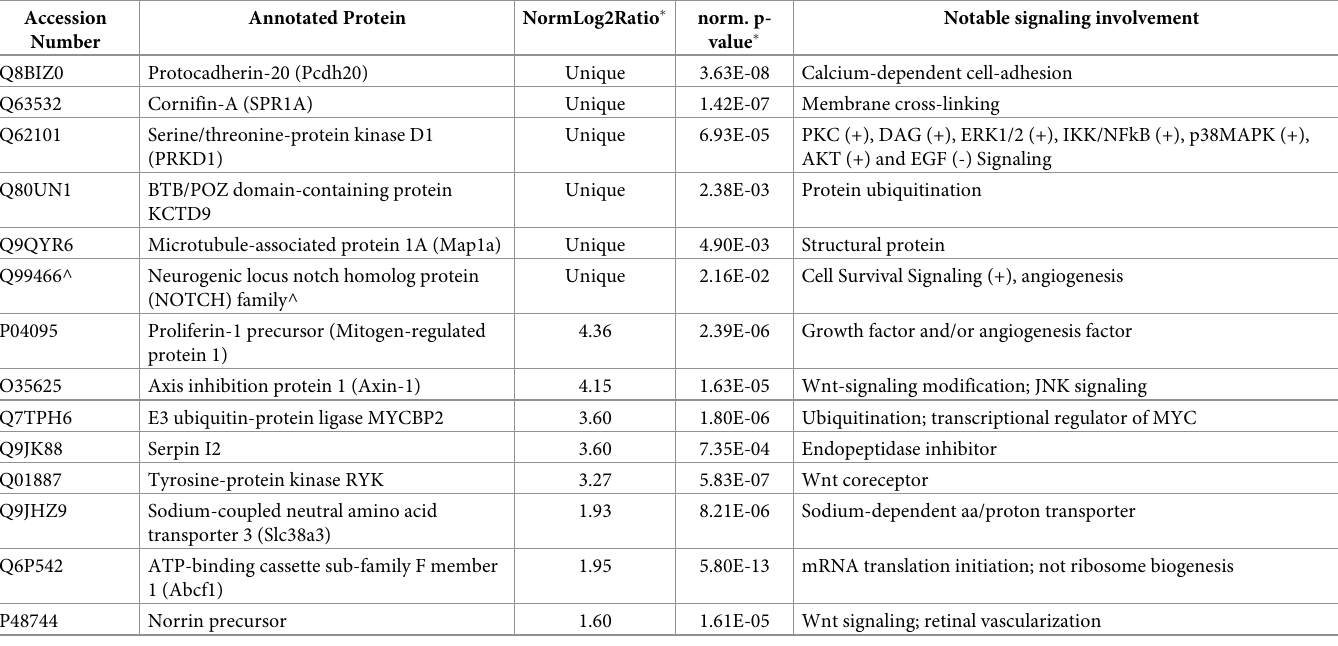
Table 2. Ang-(1–7) stimulated MAS1 receptor immuno-precipitation divergent ‘top proteomic